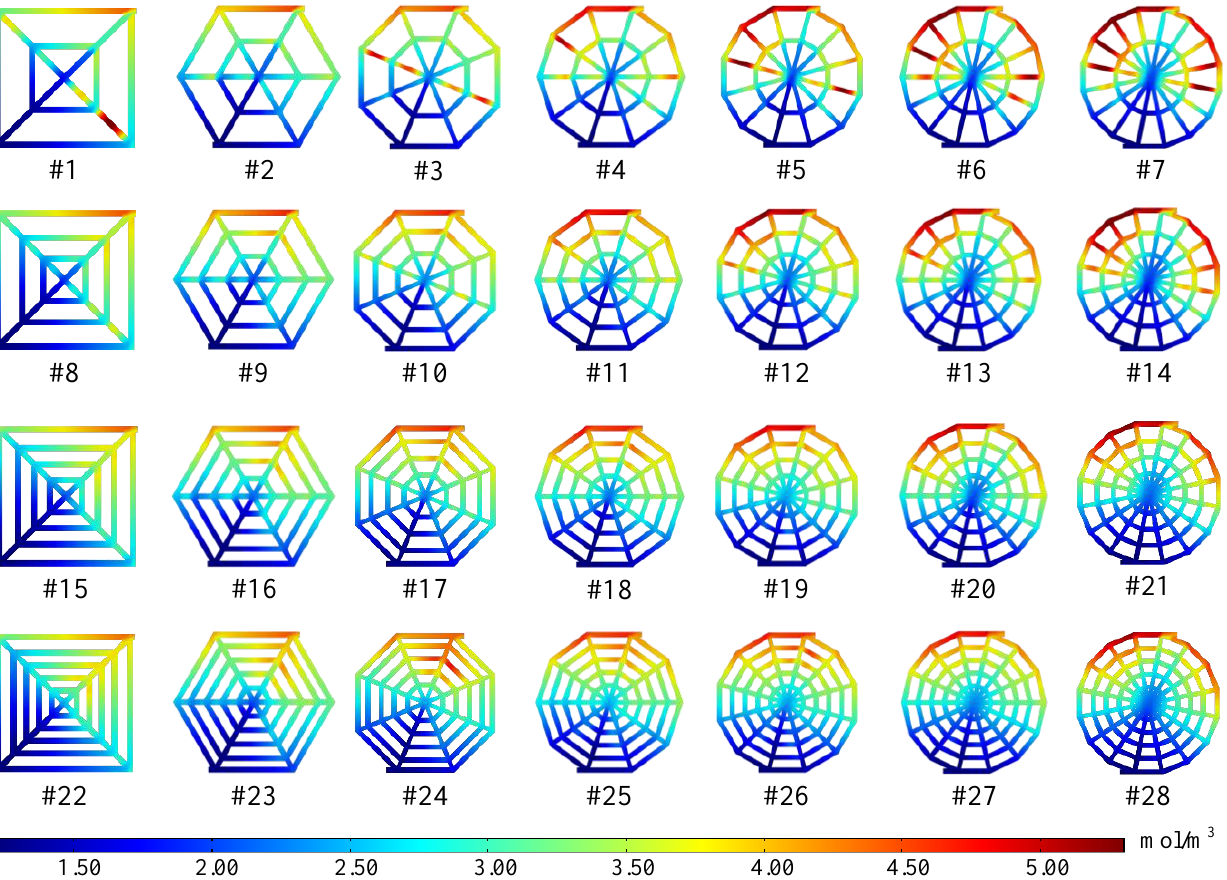
Figure 8. The water distribution of different schemes in the cathode flow field.